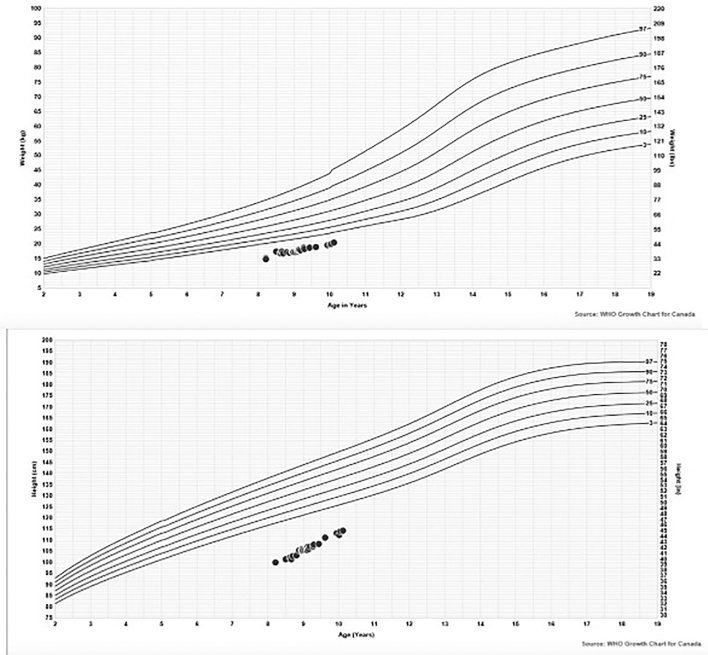
All weight and height measurements are depicted in Fig. 1.